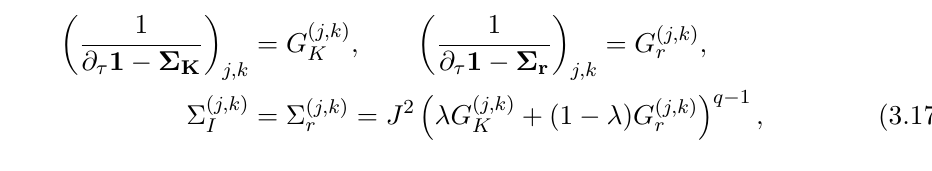
Figure 4. On the left we illustrate the correlator h β | ψ L ( τ )( ρ 2 topologies of the wires and the dashed lines are meaningful, we can write this diagram as on the right, where it looks like a standard replica contour. Black dots connected by dashed lines are at the same Euclidean